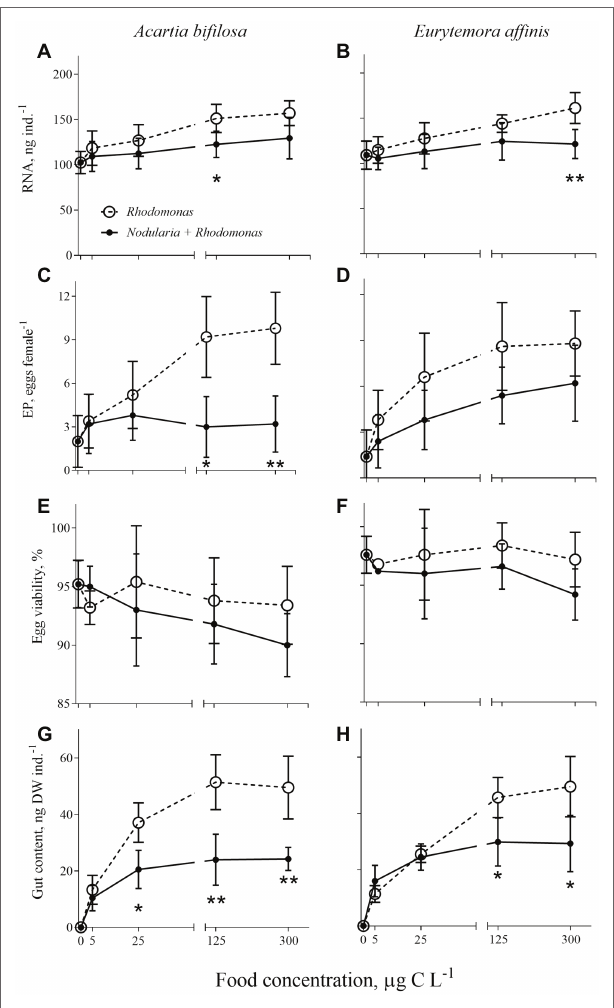
FIGURE 2 | Acartia bifilosa (A,C,E,G) and Eurytemora affinis (B,D,F,H) : effects of diet (mixed R. salina and N. spumigena vs. R. salina ) and food concentration (0–300 μ g C L − 1 ) on (A,B) individual RNA content, ng female − 1 ; (C,D) egg production, EP, egg female − 1 ; (E,F) egg viability, %; and (G,H) gut content, ng DW ind. − 1 . The data are presented as mean ± SD ( n = 5 in all cases); * p < 0.05, ** p < 0.01, *** p < 0.001 when compared to the respective nontoxic